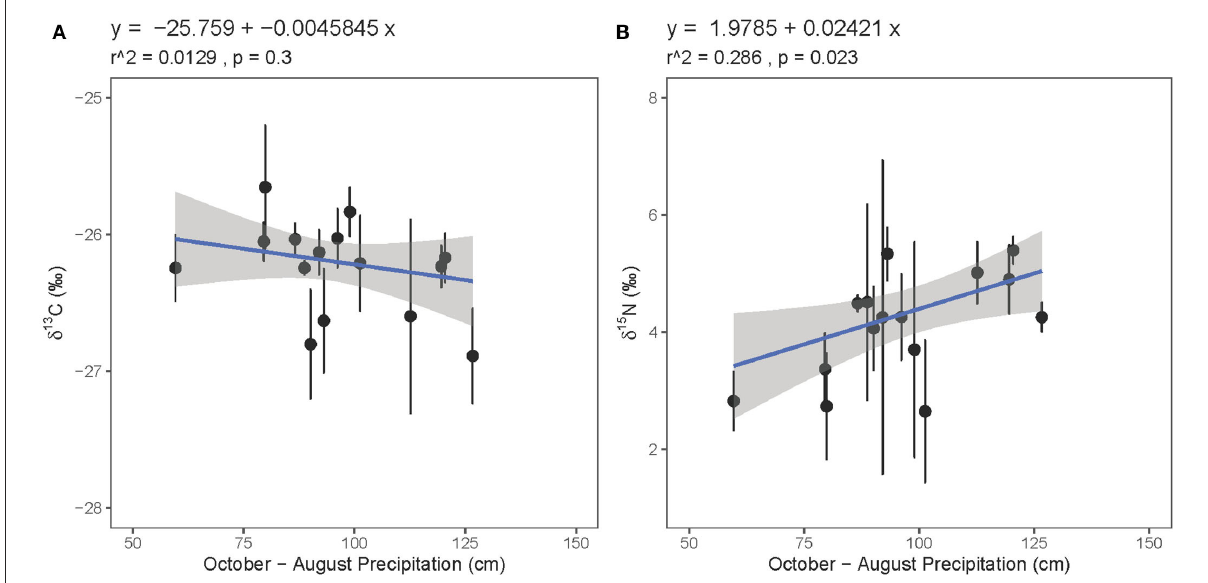
FIGURE8 Relationship between bat guano core (A) δ 13 C and (B) δ 15 N values with precipitation amount from the previous year through the growing season